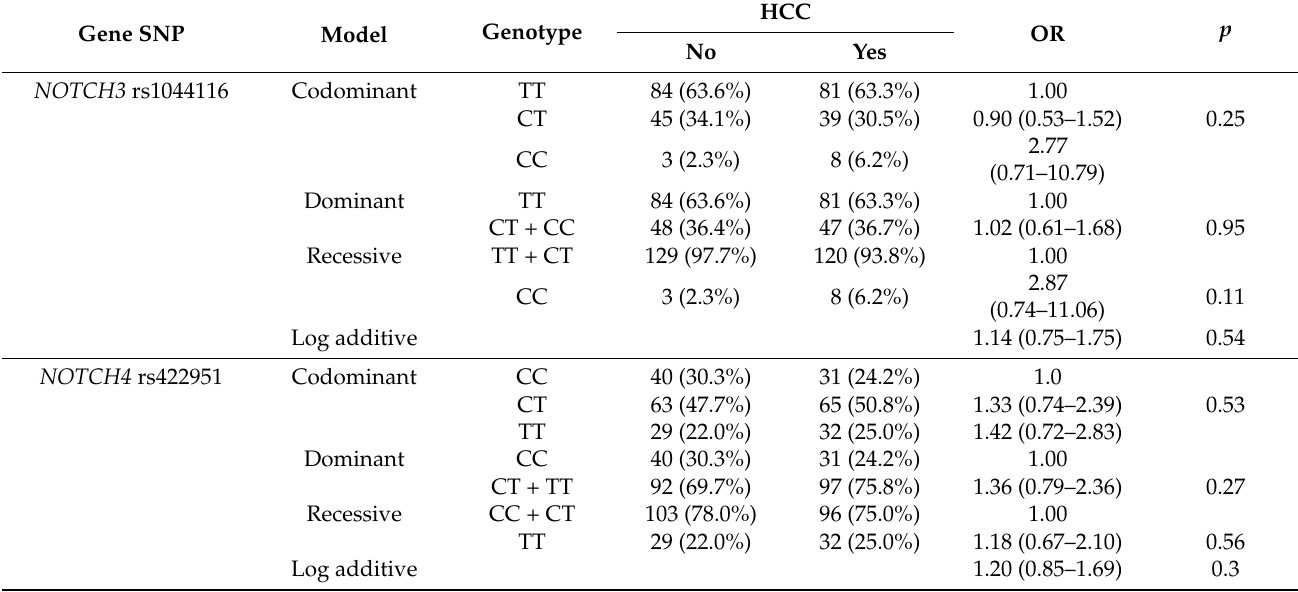
Table 4. Cont. Table 5. Logistic regression analysis of predictors for hepatocellular carcinoma development.